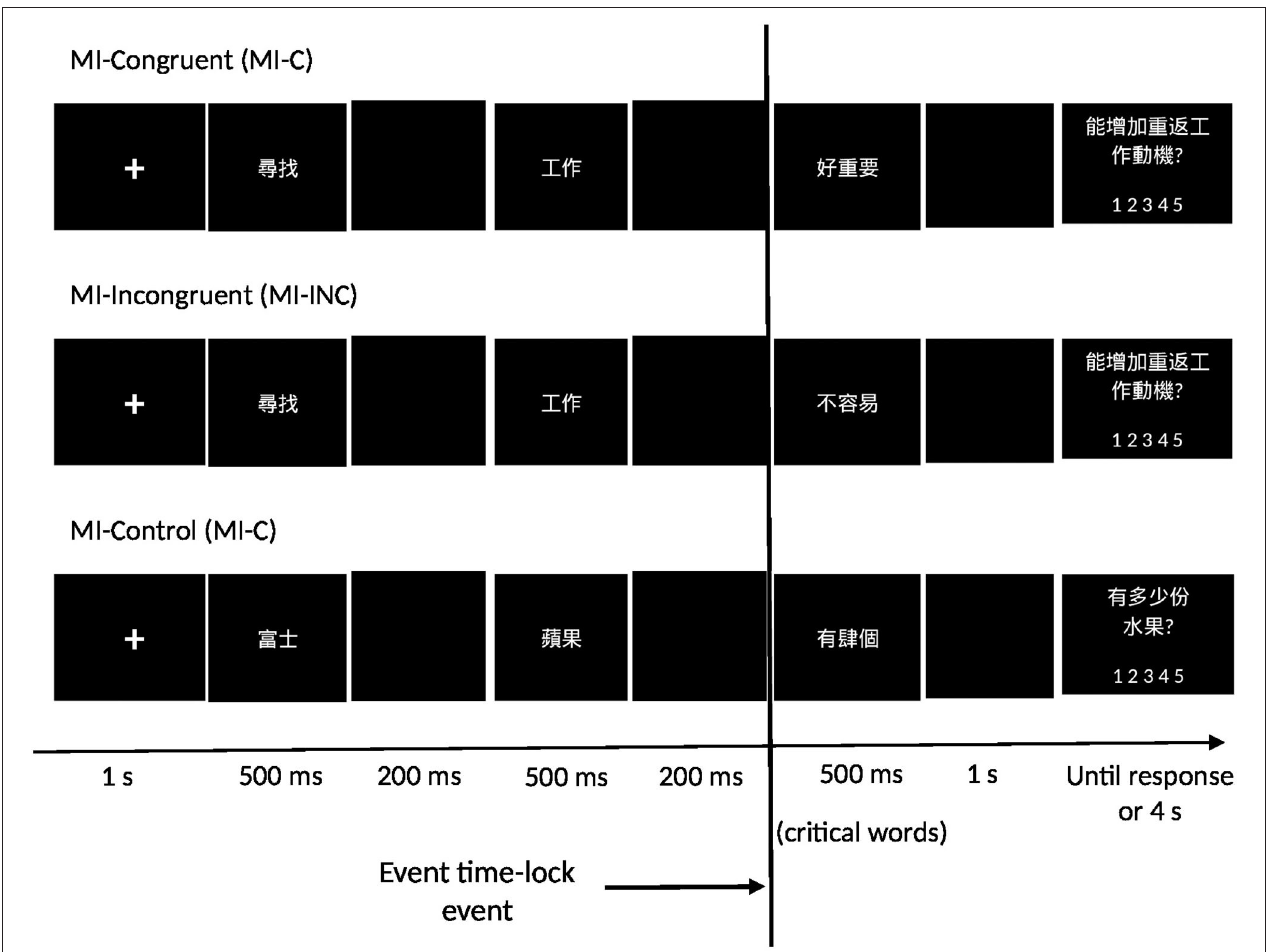
FIGURE 1 | Design of the trials in the Ml-congruent, Ml-incongruent, and Ml-control conditions.